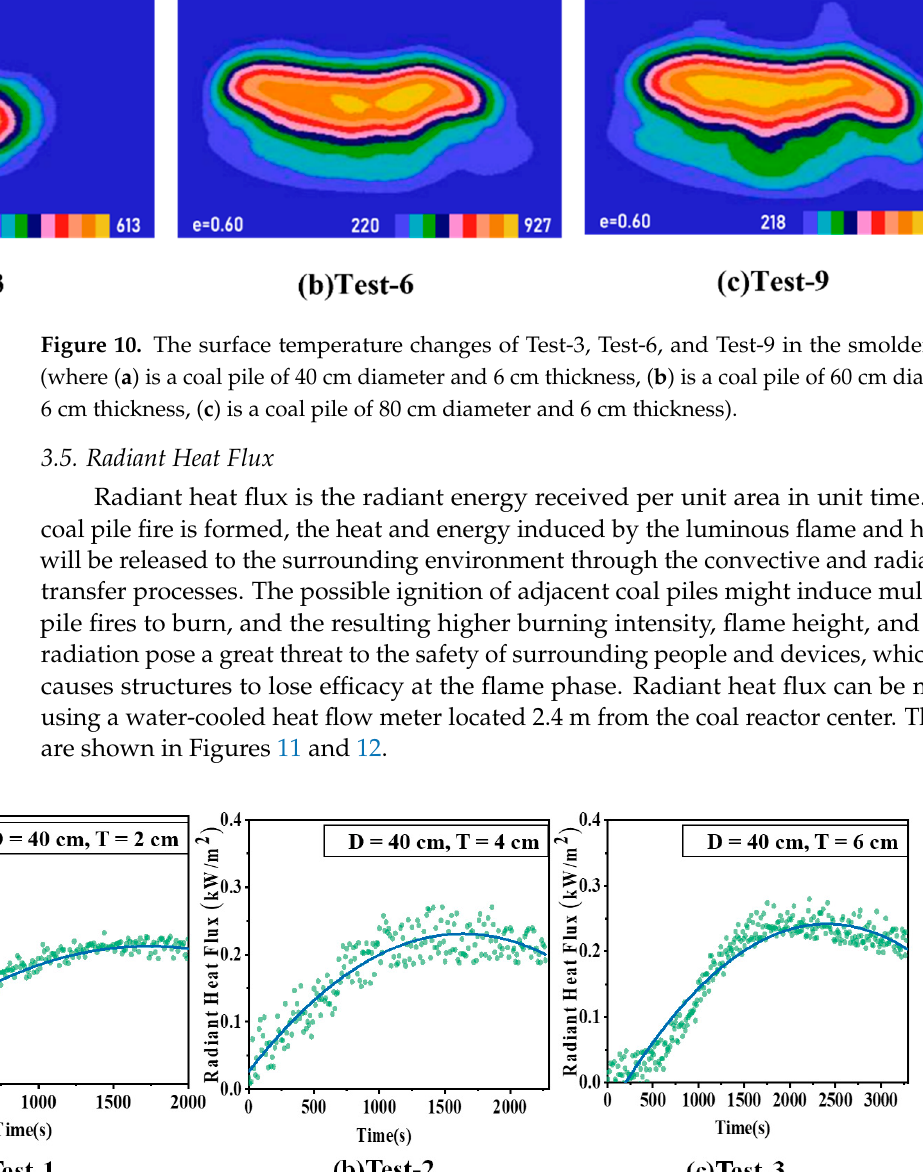
Figure 12. The radiant heat fl ux changes of Test-2, Test-5, and Test-8 (where ( a ) is a coal pile of 40 cm diameter and 4 cm thickness, ( b ) is a coal pile of 60cm diameter and 4 cm thickness, ( c ) is a coal pile of 80cm diameter and 4 cm thickness). According to Figures 10 and 11, the maximum heat radiation fl ux at the stable stage was 0.25 KW/m 2 , and the heat radiation fl ux changes depend on the diameter, not the thickness. Figure 13 shows the relationship between the coal pile’s diameter and its heat radiation fl ux using the linear fi tt ing method. When the thermal radiation fl ux safety cri- terion for destroying the coal bunker is 25 KW/m 2 and the thermal radiation damage guidelines from relevant articles are considered, the following equation (Equation (3)) can be used. If the distance between the coal pile and the coal bunker is 2.4 m, the maximum diameter is 587 cm. 𝑌 = −0.001𝑥 (cid:2870) + 0.0187𝑥 − 0.32 (3) where Y is the radiant heat fl ux (KW/m 2 ) and x is the coal pile diameter (cm).